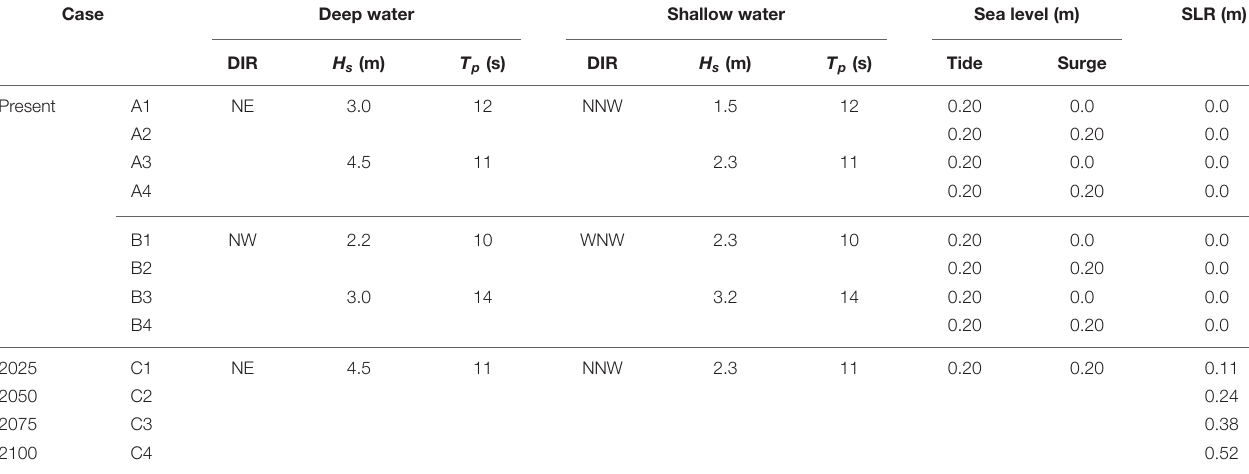
TABLE 2 | Propagation cases for determining run up in Bocagrande beaches. Case Deep water Shallow water Sea level (m) SLR (m)